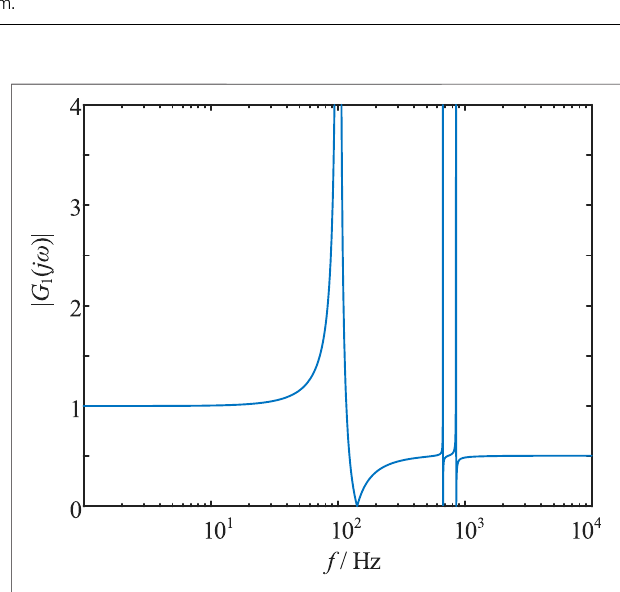
FIGURE 1 | Topology diagram of the Kunliulong hybrid multiterminal UHVDC system.